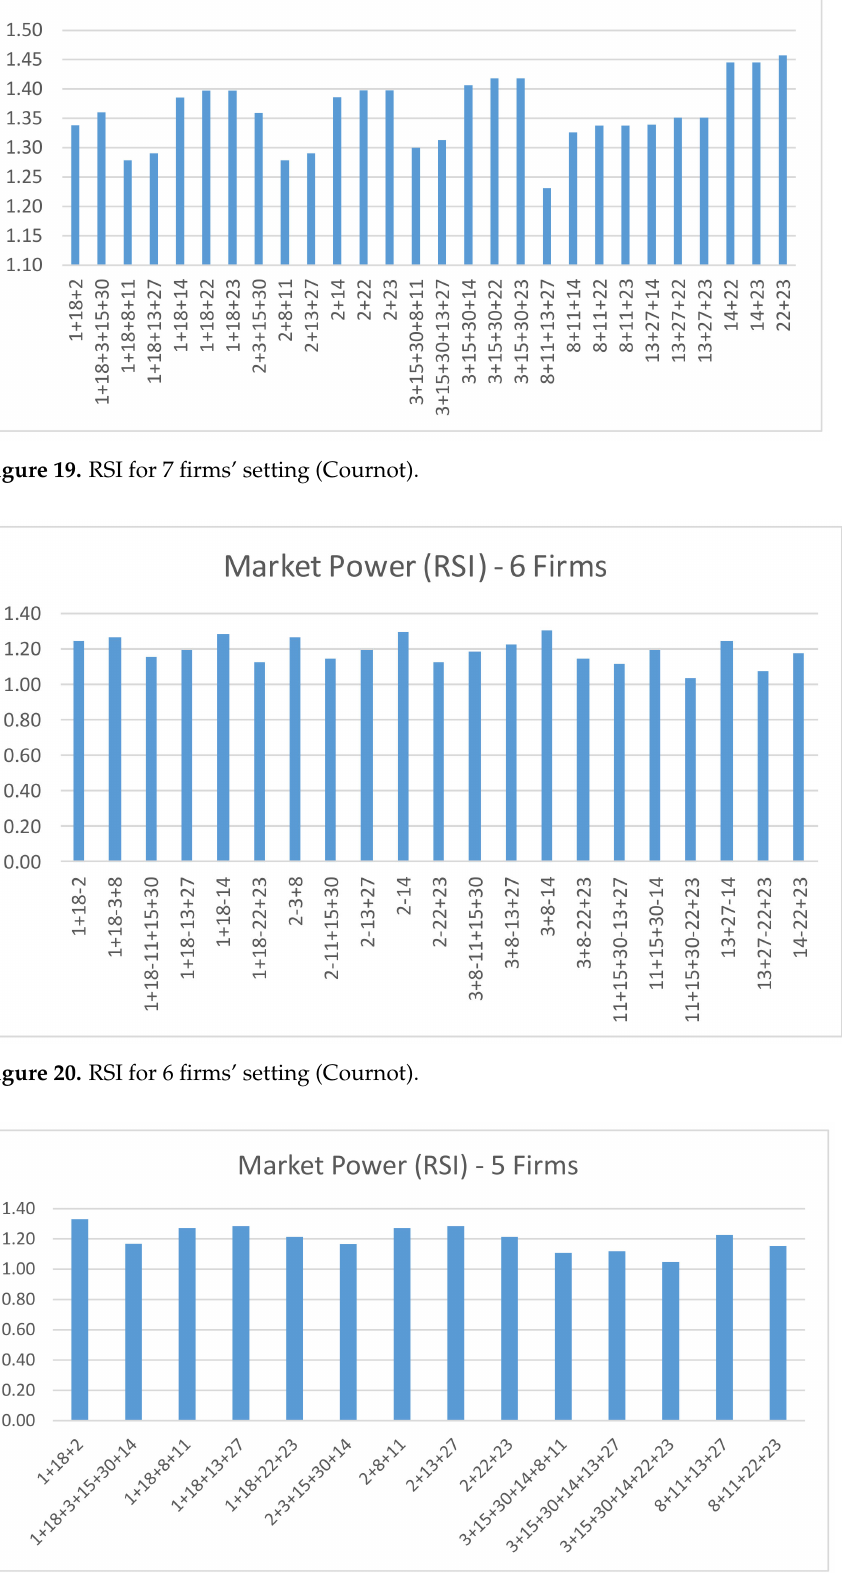
Figure 21. RSI for 5 firms’ setting